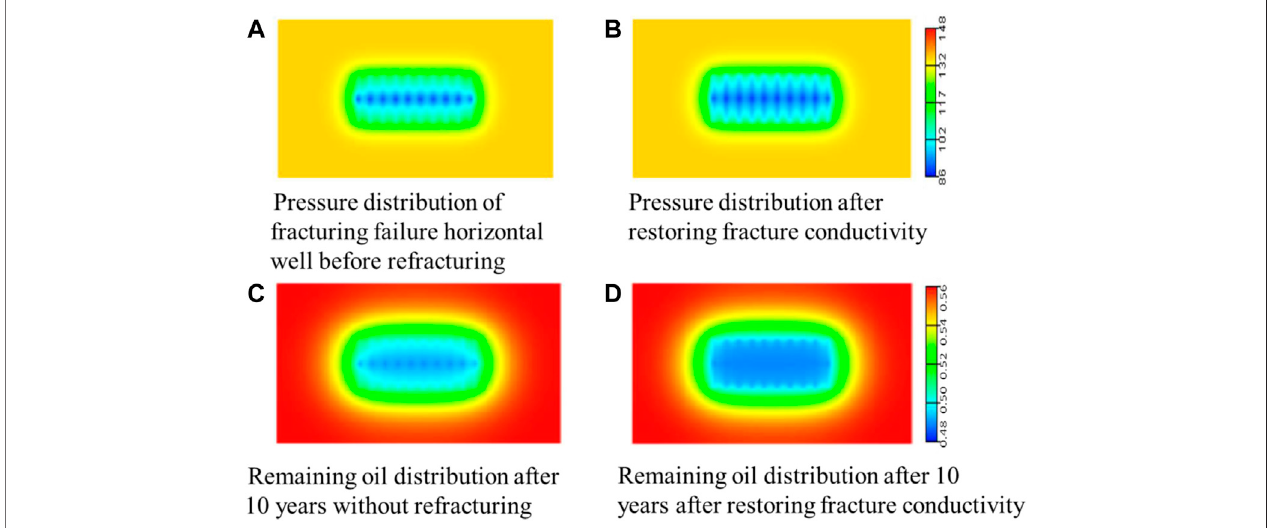
FIGURE 9 | Pressure distribution before and after recovery of fracture conductivity. (A) Pressure distribution of fracturing failure horizontal well before refracturing. (B) Pressure distribution after restoring conductivity. (C) Remaining oil distribution after 10 years without refracturing. (D) Remaining oil distribution after 10 years after restoring